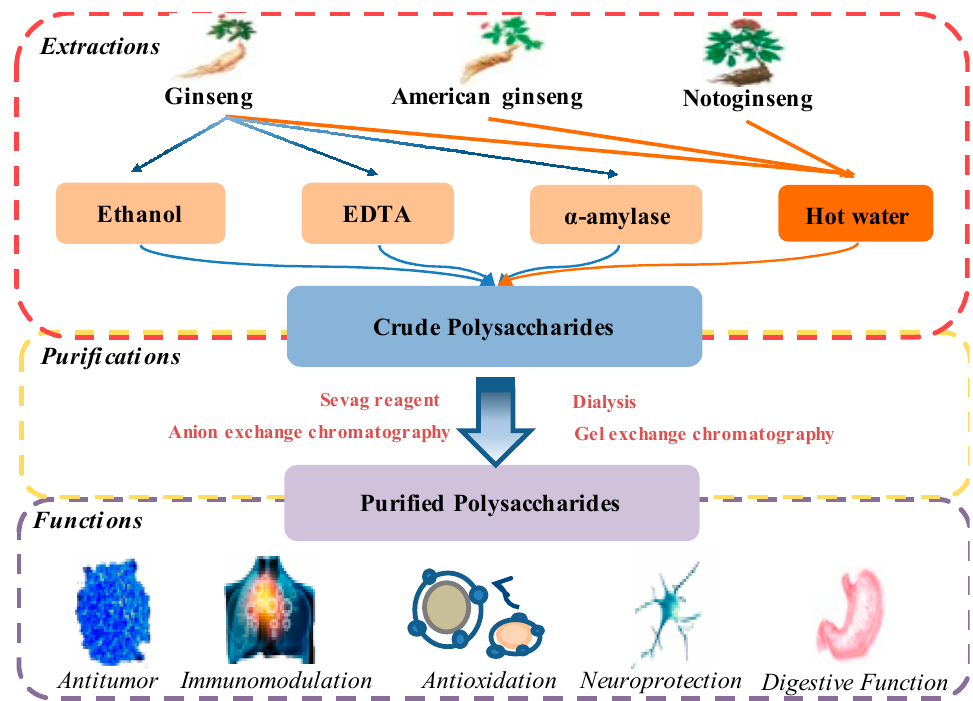
Figure 3. Summary for extraction, purification, and functions of the polysaccharides from three spe- cies.